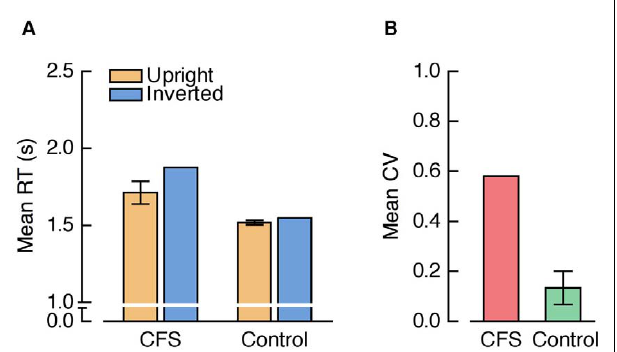
SD divided by the mean) from Experiment 1. In this and all further graphs depicting CVs, positive and negative error bars denote 95% confidence intervals for the paired comparison between the CFS and the control